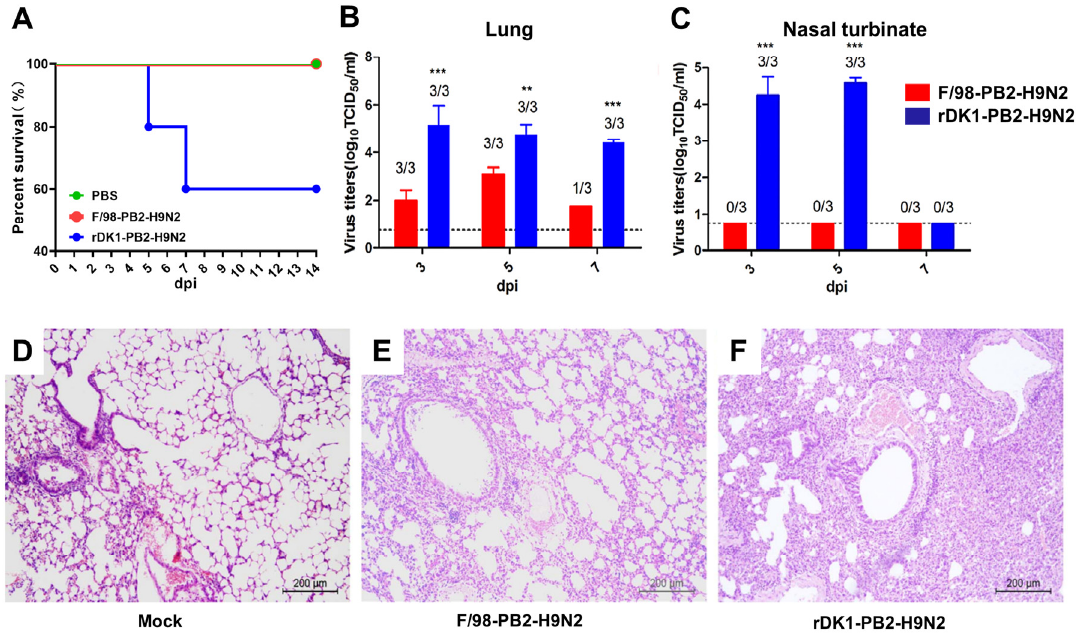
Figure 2. DK1-like PB2 enhances the replication and pathogenicity of H9N2 AIV in mice. Mice were infected with the virus at 10 6 TCID 50 , the survival of the mice was monitored within ( A ) 14 days and the ( B ) lungs and ( C ) turbinates of the mice were taken 3, 5 and 7 days after infection to detect the virus titer using the TCID 50 assays; ( D – F ) The lung samples infected with the virus for 5 days were fixed with 10% phosphate-buffered formalin, paraffin sections were made, and HE staining was performed to observe the pathological damage of the lungs of mice. Differences were considered statistically significant at p < 0.05 (** p < 0.01, and *** p < 0.001, ANOVA).